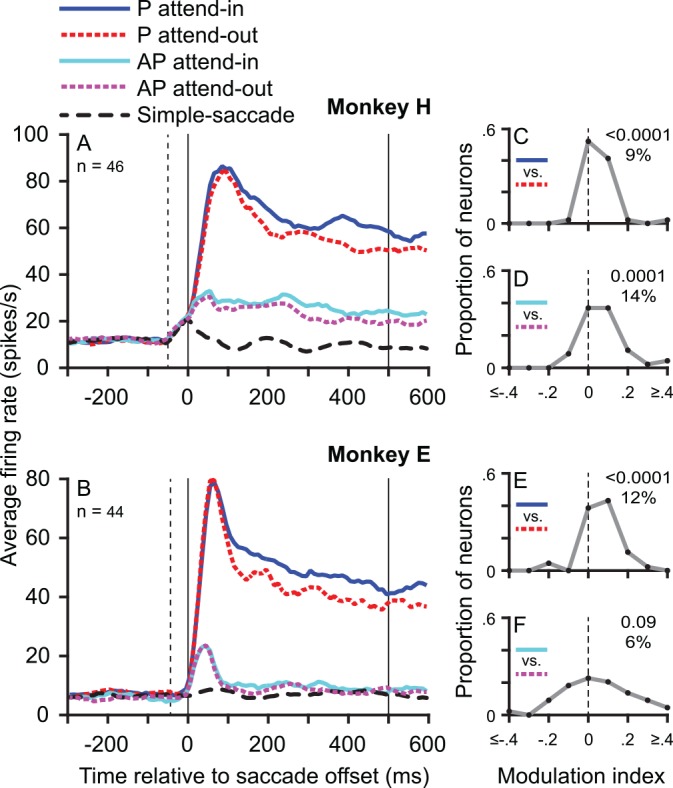
Attentional enhancement of MT neuronal responses to moving RDPs.(A,B) Population average peristimulus time histograms (PSTHs) for monkey H (A) and monkey E (B) in response to attended (target) and unattended (distractor) RDPs moving either in the preferred (P) or antipreferred (AP) direction (see legend at top left). The PSTH for the simple-saccade task is also shown in black as a reference. Solid vertical lines demarcate the time window used for computing the modulation indices in C–F. The dotted vertical line indicates the mean time of saccade onset. (C,E) Frequency polygons of the distribution of modulation indices in monkey H (C) and monkey E (E) when the preferred direction RDP is in the RF after the saccade show a clear predominance of values greater than zero, i.e., an enhanced response in the attend-in conditions. The p-value from the signed-rank test of the modulation indices and the median modulation index (converted to a percentage and rounded) are shown on the top right of each panel. The final point in the frequency polygons sums all data values at or beyond the extreme value. (D,F) Same as C,E but for the antipreferred direction RDP. Data in Supporting Information (S1 Data).